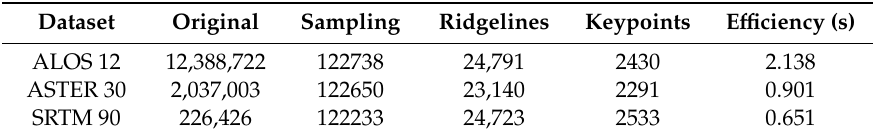
Table 2. Number and e ffi ciency of keypoint extraction.